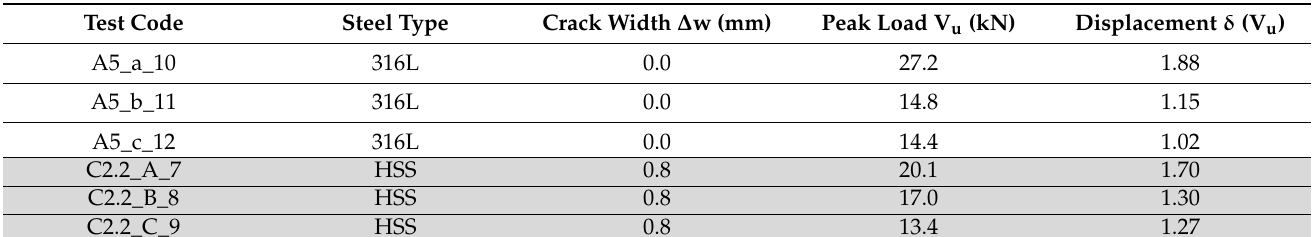
Table 5. Test results of shear loading.